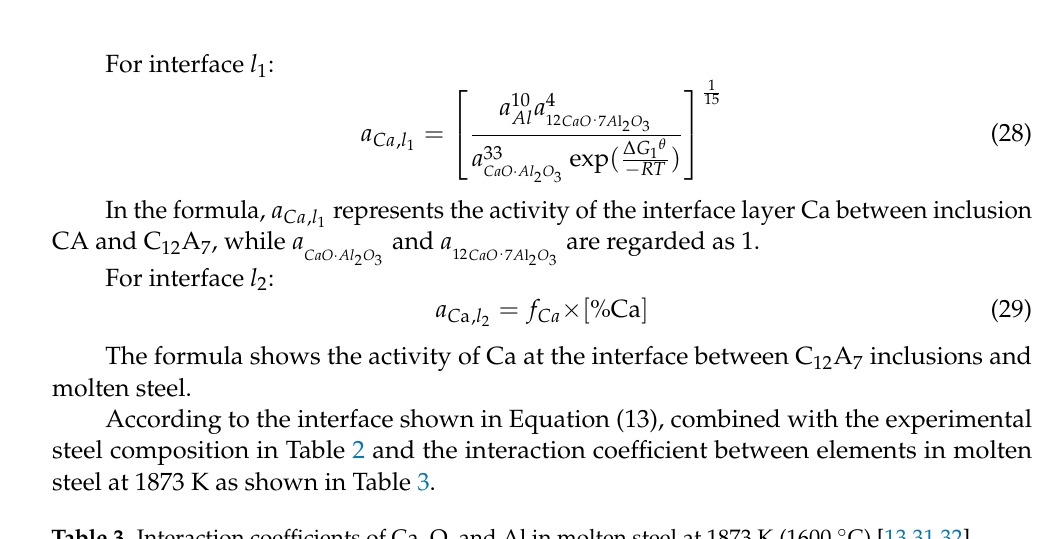
Table 3. Interaction coefficients of Ca, O, and Al in molten steel at 1873 K (1600 °C) [13,31,32].